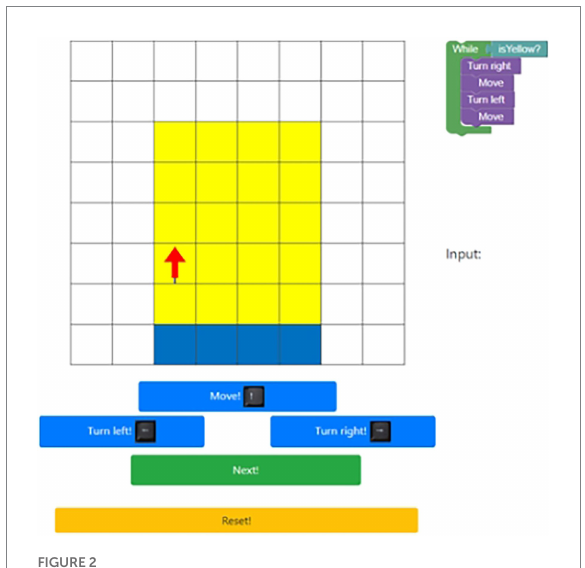
FIGURE 2 Presentation of test environment for an item in Progly.